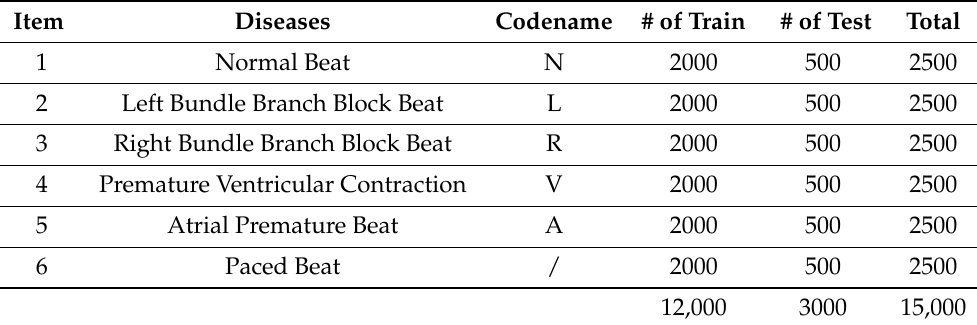
Table 6. The numbers of ECG segments used for training and testing processes for each type of ECG